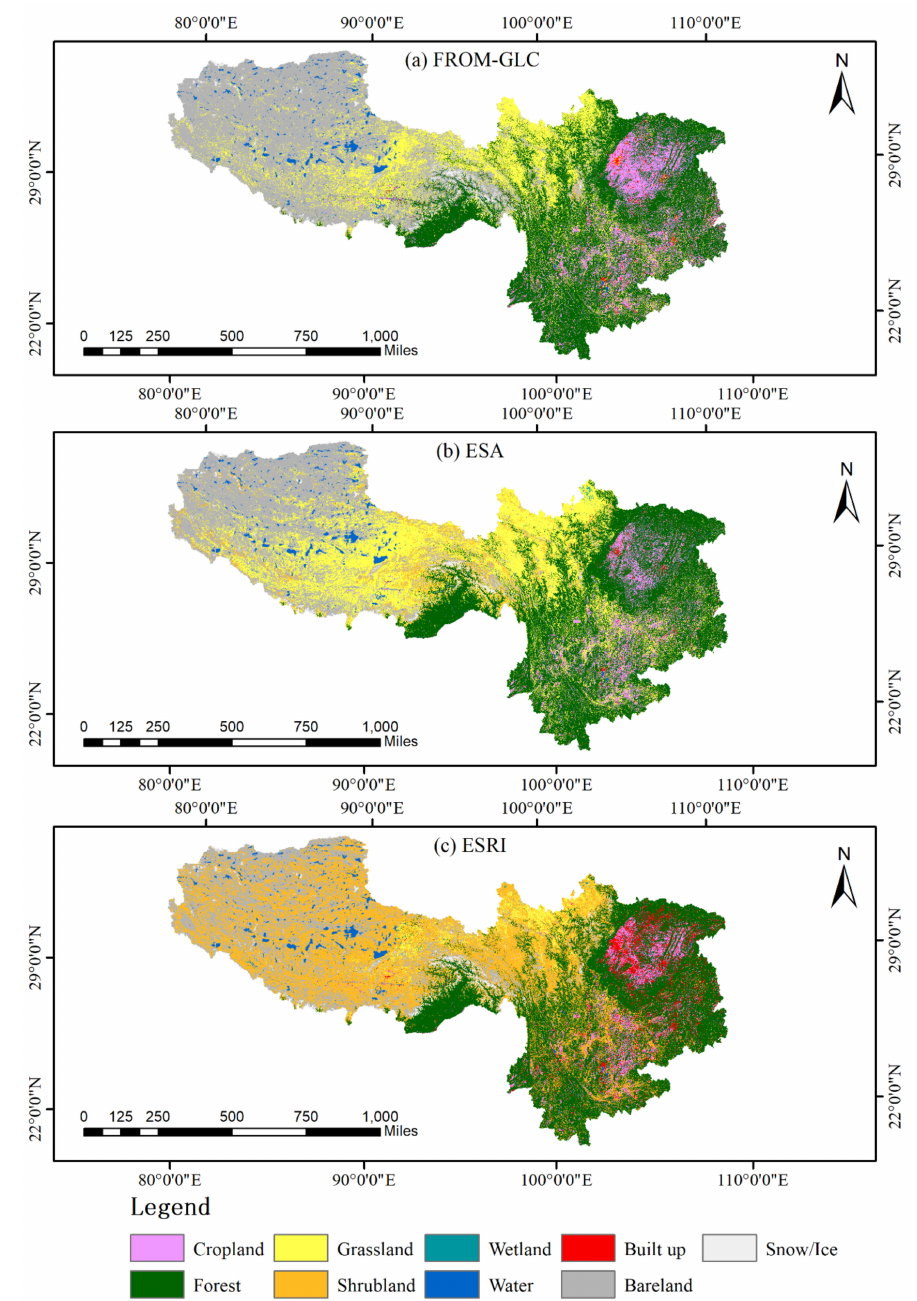
Figure 2. Spatial distributions of the three land cover products in southwest China: ( a ) FROM-GLC, ( b ) ESA, and ( c )